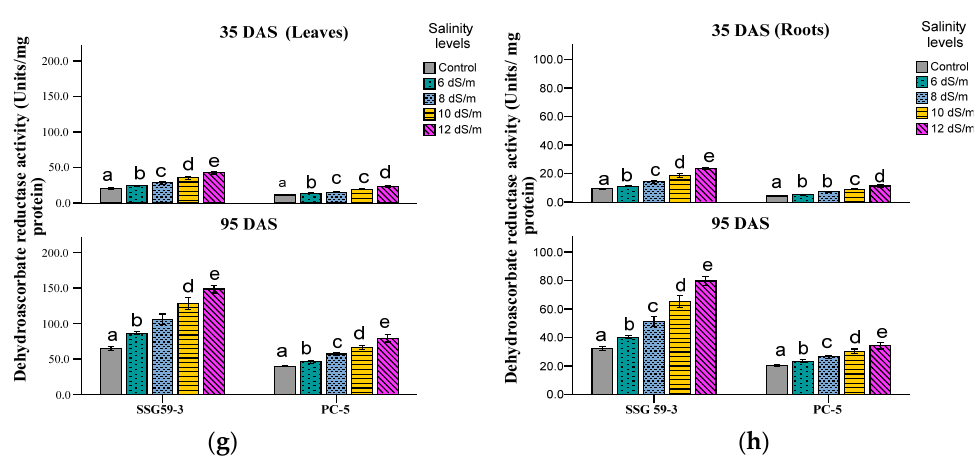
Figure 7. Effect of salt stress on glutathione peroxidase (GPX, ( a , b )), glutathione reductase (GR, ( c , d )), monodehydroascorbate reductase (MDHAR, ( e , f )), and dehydroascorbate reductase (DHAR, ( g , h )) of sorghum genotypes at 35 and 95 DAS. Post hoc comparisons of the means were performed using Tukey’s HSD test at p < 0.05; different letters ( a–e ) indicate significant differences among treatments within each genotype.